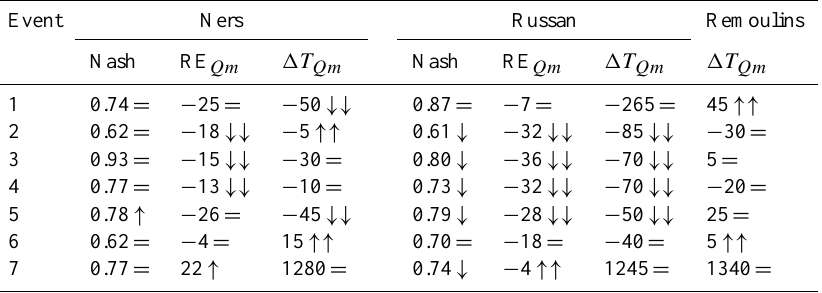
Table 7. LR option results. Performance indexes at the Ners, Russan and Remoulins stations. The symbols on the right of the indexes characterise the gaps compared with the COUPL MOD option. ↓↓ : deterioration of more than 50%; ↓ : deterioration of between 5 and 50%; ↑ : improvement of between 5 and 50%; ↑↑ : improvement of more than 50%; = : close values, within ± 5%. Symbol also attributed to RE Qm , if the absolute difference is lower in ± 10%, and for 1T Qm , if the absolute difference is lower in ± 15min. Event Ners Russan